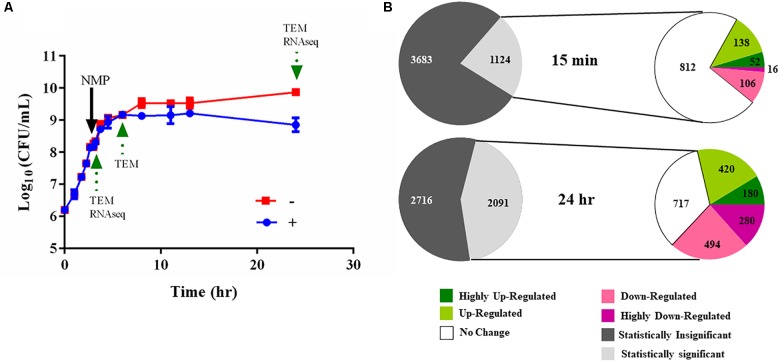
Experimental design of the RNA-seq experiments. (A) Typical bacterial growth curve measured at 37°C in MH broth in the presence of the 250 μg/mL NMP and the control solvent DMSO. NMP was added when OD600
nm of the culture reached mid-log phase (0.6 approximately after 3 h of growth). The sign ‘–’ denotes DMSO and ‘+’ denotes DMSO plus NMP. Samples were taken for transmission electron microscopy (TEM) and for RNA purification as indicated by green arrows at time points 15 min, 3 and 21 h following exposure. (B) Overview of the number of the differentially regulated genes identified using RNA-seq. The gray and white colored pie chart [upper] depicts the number of genes for which statistically significant data (Voom, P < 0.05) was obtained from the two time points. The second pie chart [lower] depicts the number of up- and down-regulated genes at the respective time point. The color of each pie represents the relative gene expression based on the color scale given below.